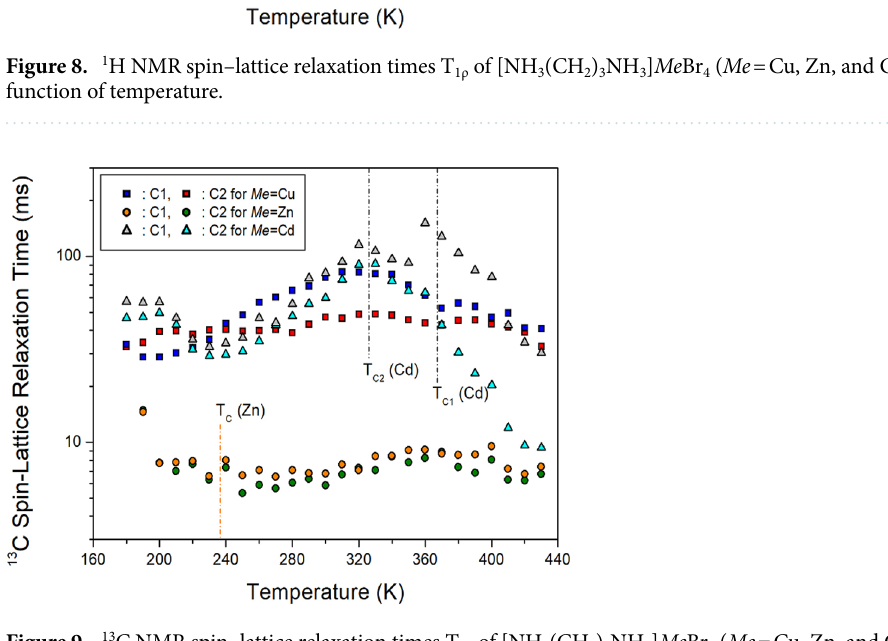
Figure 9. 13 C NMR spin–lattice relaxation times T 1ρ of [NH 3 (CH 2 ) 3 NH 3 ] Me Br 4 ( Me = Cu, Zn, and Cd) as a function of